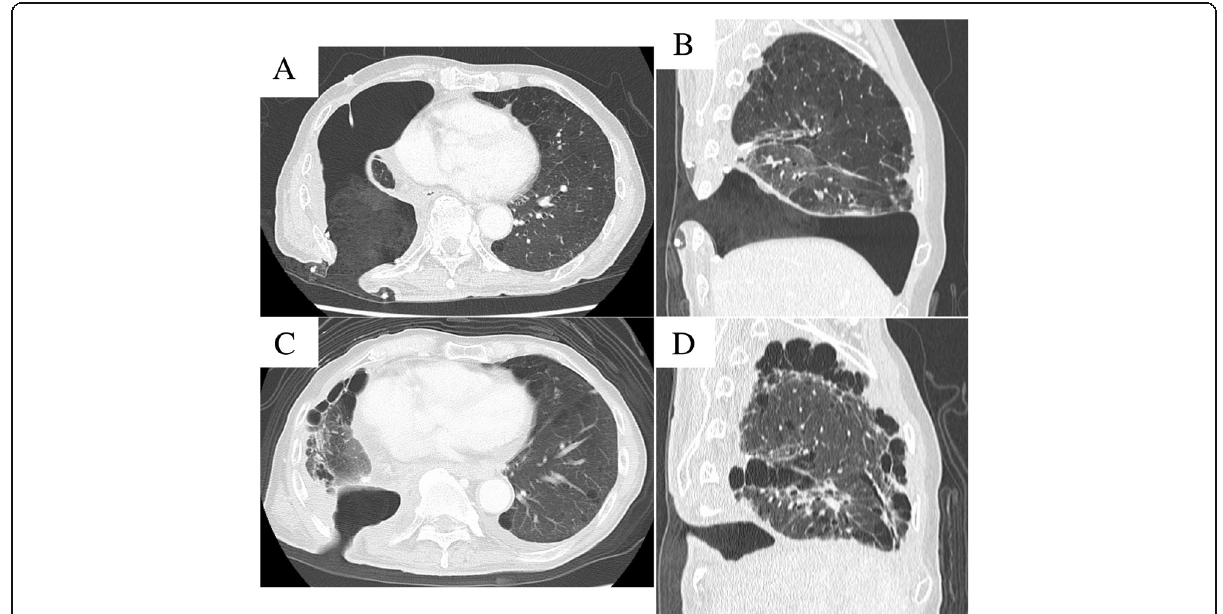
Fig. 3 The CT shows the change of the thoracic cavity after fenestration surgery. The image obtained 1-month post-procedure ( a axial view,